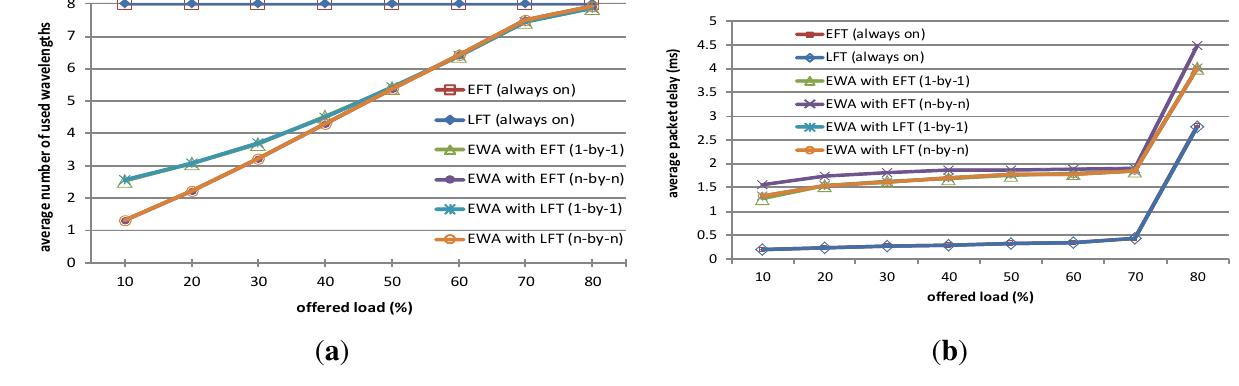
Figure 4. EWA with LFT and EFT wavelength allocation. ( a ) Number of Wavelengths used; ( b ) Average packet